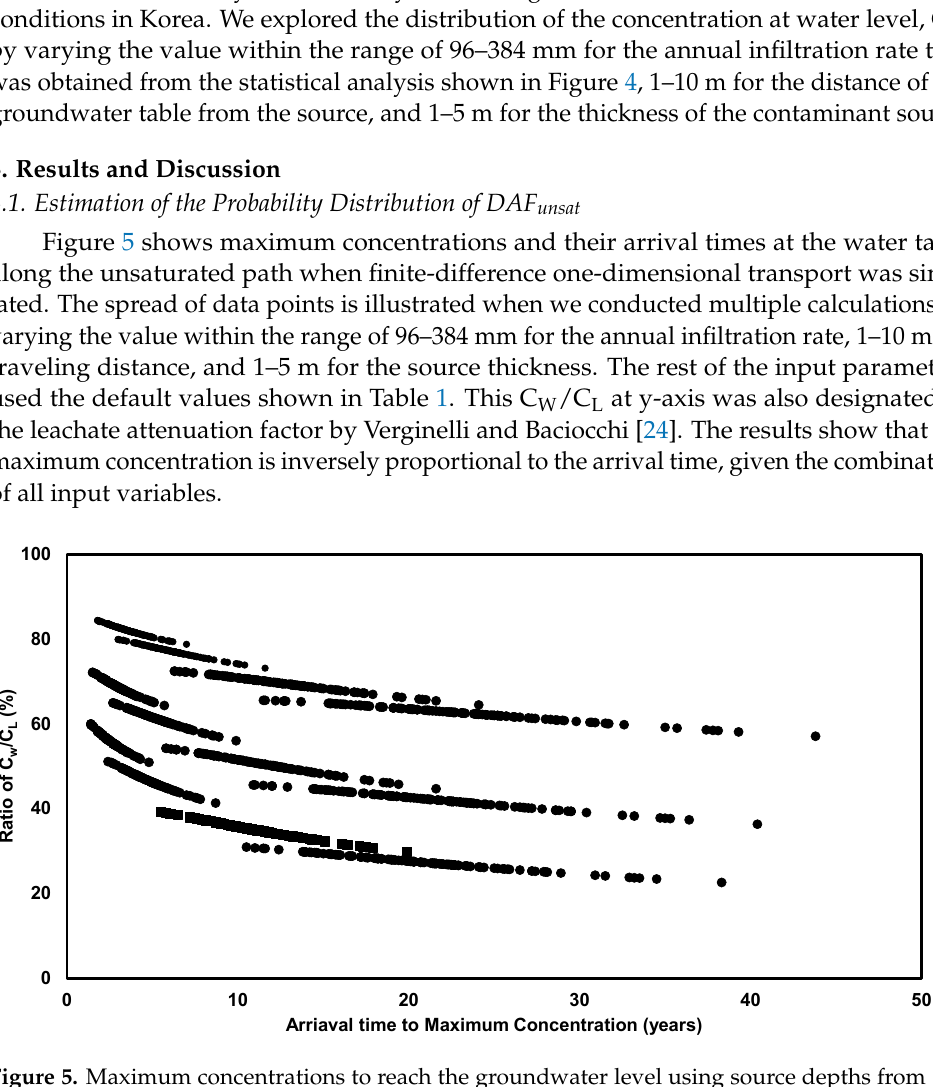
Figure 5. Maximum concentrations to reach the groundwater level using source depths from 1 to 5 m and distances from 1 to 10 m for the soil-to-groundwater pathway. an indicator from the Ryu [25] defined as the ratio of the concentration of the source to the concentration at the water table. Since we deal with time-varying concentrations in this study, we redefined DAF unsat as the ratio of the initial source concentration to the highest